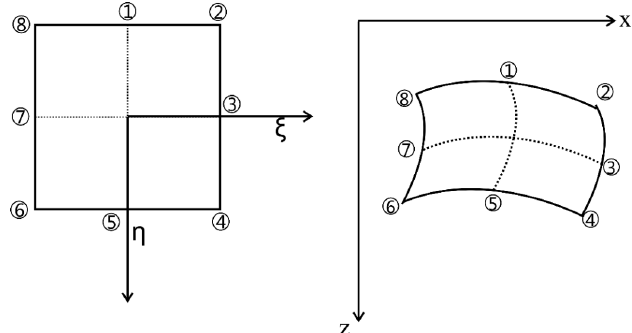
Figure 3. Points quadrilateral element with curved sides: ( left ) the ξη -plane and ( right ) the xz-plane.